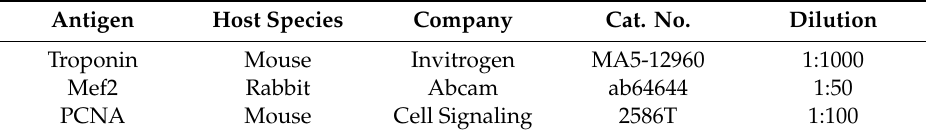
Table A1. Primary antibodies.